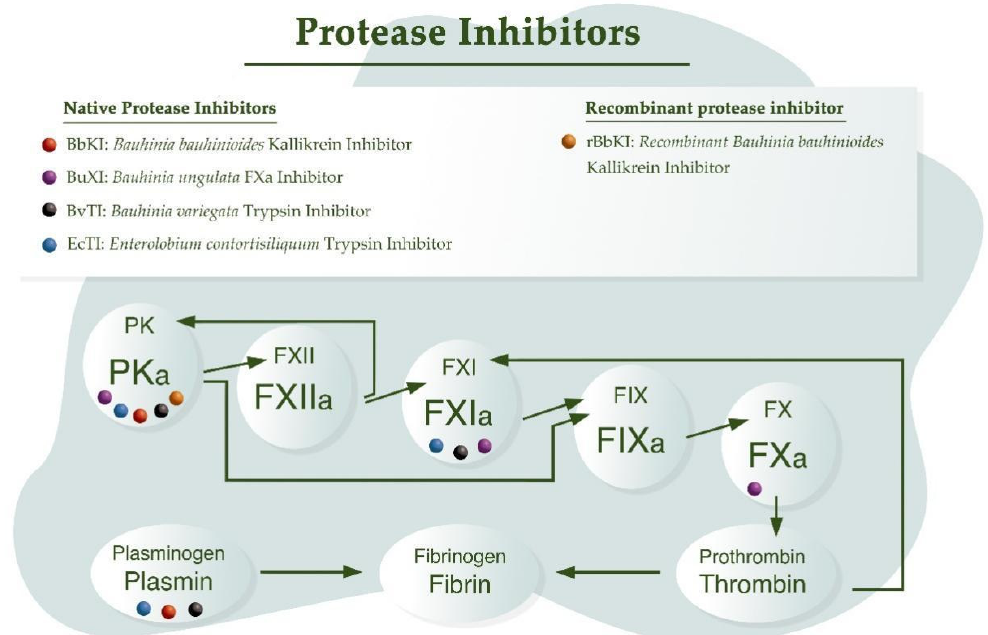
Figure 3. Activity of plant Kunitz inhibitors on some intrinsic pathway clotting enzymes, and on fibrinolytic enzymes. Coagulation cascade scheme based on Kearney et al. [98].